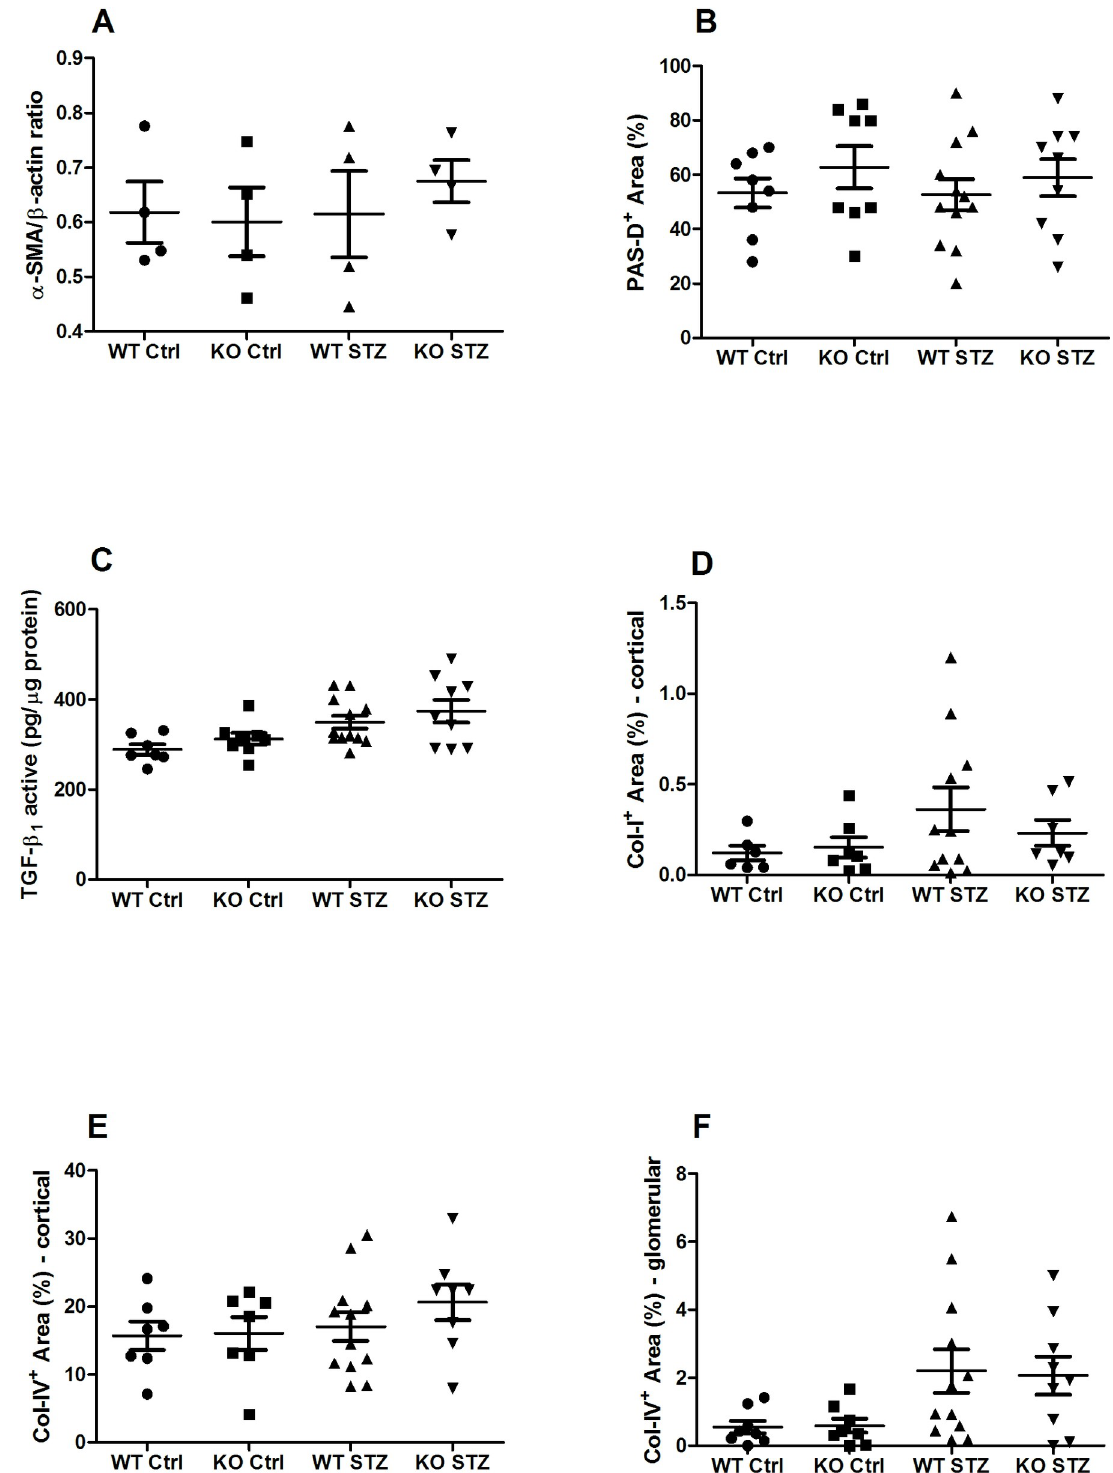
Fig 5. Renal fibrosis markers:, α -SMA, mesangial cellularity active TGF- β 1, collagen I, and collagen IV. (A) Expression of α -SMA mRNA in renal tissue. (B) Quantification of mesangial cellularity in PAS-D-stained renal sections. (C) Protein expression of active TGF- β 1, measured by ELISA in kidney homogenate. (D-F) Quantification of collagen I (cortical) and collagen IV (cortical and glomerular) stainings in renal tissue. Data shown as mean ± SEM. α -SMA = alpha smooth muscle actin; TGF- β 1 = Transforming Growth Factor-Beta